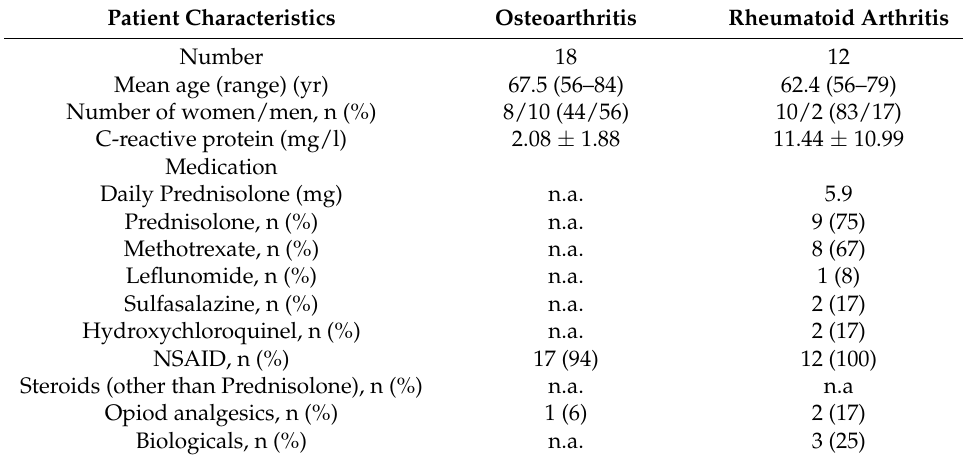
Table 1. Characteristics of patients under